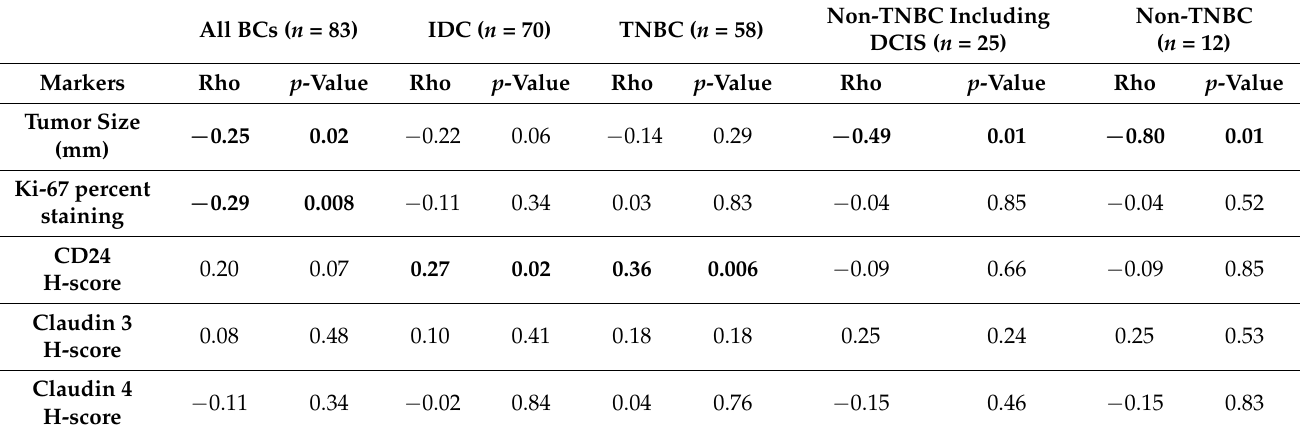
Figure 2. Analysis of TBC1D9 expression in BC cohorts. The differences in the expression patterns of TBC1D9 in DCIS, non-TNBC, and TNBC tissue samples in our cohort ( A ). Expression of TBC1D9 in different subtypes of BC: DCIS ( n = 12), luminal A ( n = 4), luminal B ( n = 4), HER2 ( n = 4), and TNBC ( n = 13) ( B ). Expression of TBC1D9 in different subtypes of BC: DCIS ( n = 13), luminal A ( n = 4), luminal B ( n = 4), HER2 ( n = 4), and TNBC ( n = 58) ( C ). Spearman correlation between mRNA and protein expression of TBC1D9 in BC tissue samples from our cohort ( D ). Expression pattern of TBC1D9 in BC tissue samples according to grade in our cohort ( E ) and a cohort from the online database GENT2 ( F ). Table 1. Spearman correlations of markers with H-scores for TBC1D9